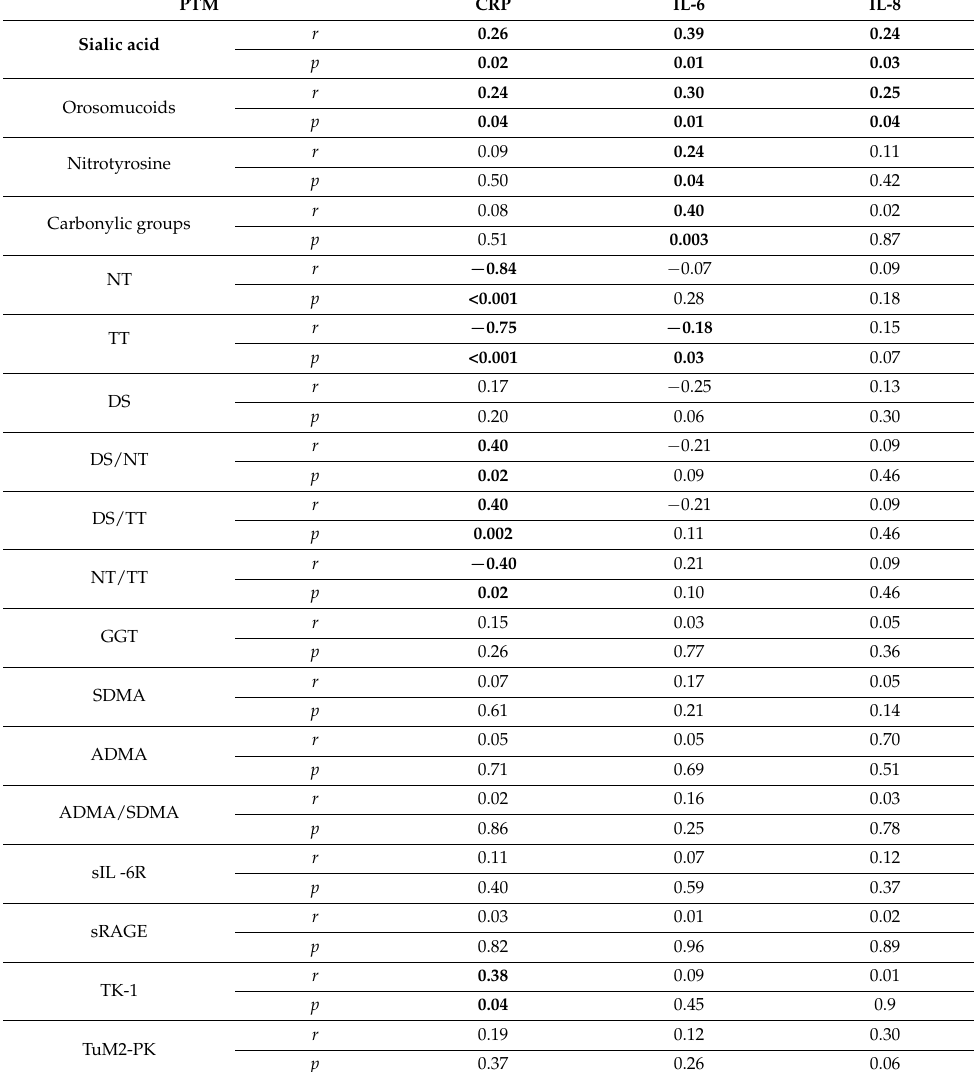
the result of phosphorylation strongly correlated with CRP (rho = 0.38, p = 0.04) in the RCC group, and TuM2-PK moderated correlated with IL-8 (rho = 0.30, p = 0.06). Table 7. Statistical relation between PTMs and inflammatory markers in renal cell